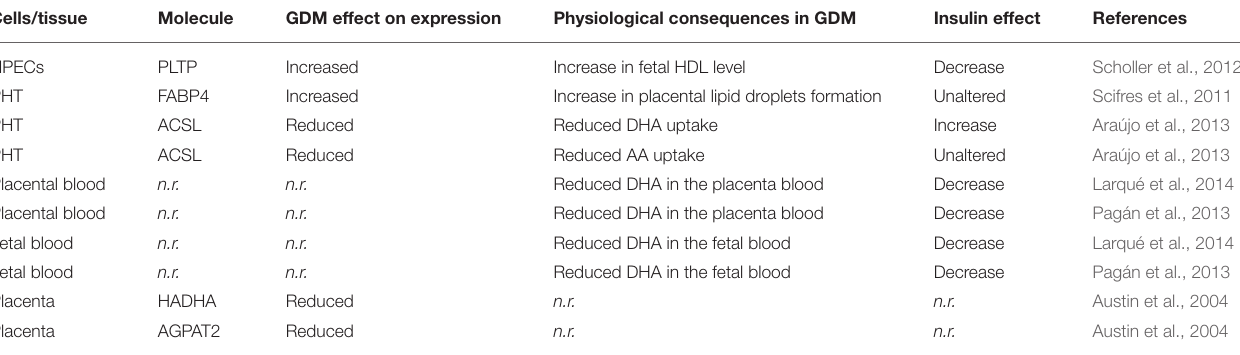
TABLE 3 | Effect of insulin on the expression of molecules involved in lipids metabolism in